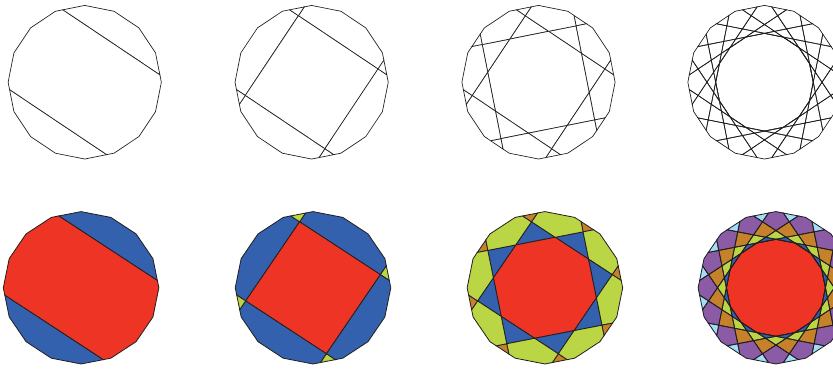
Figure 37. Cutting with d i knives ( d 2 = 2, d 3 = 4, d 4 = 8, d 5 = 16) and the resulting